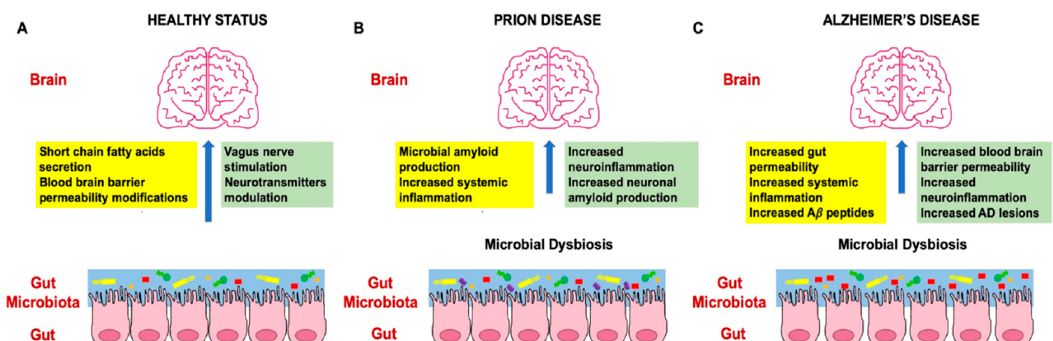
Figure 1. Relationship between the gut microbiota and the brain. ( A ) In physiological conditions, gut microbiota exerts its effects on the central nervous system using several mechanisms, including the production of short-chain fatty acids, modification of blood–brain barrier permeability, modulation of specific neurotransmitters, and vagus nerve stimulation. ( B ) In prion disease, prion agents introduced with diet give a microbial dysbiosis that, through microbial amyloid production, is able to activate the immune system, enhance microglia and astrocyte activation, and improve neuronal amyloid production and accumulation in the brain. ( C ) In Alzheimer’s disease, the microbial dysbiosis impairs gut permeability, inducing a systemic activation of the immune system; this, together with bacterial amyloid beta (A β ) fibrils, increases the neuroinflammatory status and the deposition of A β fibrils at the brain level.